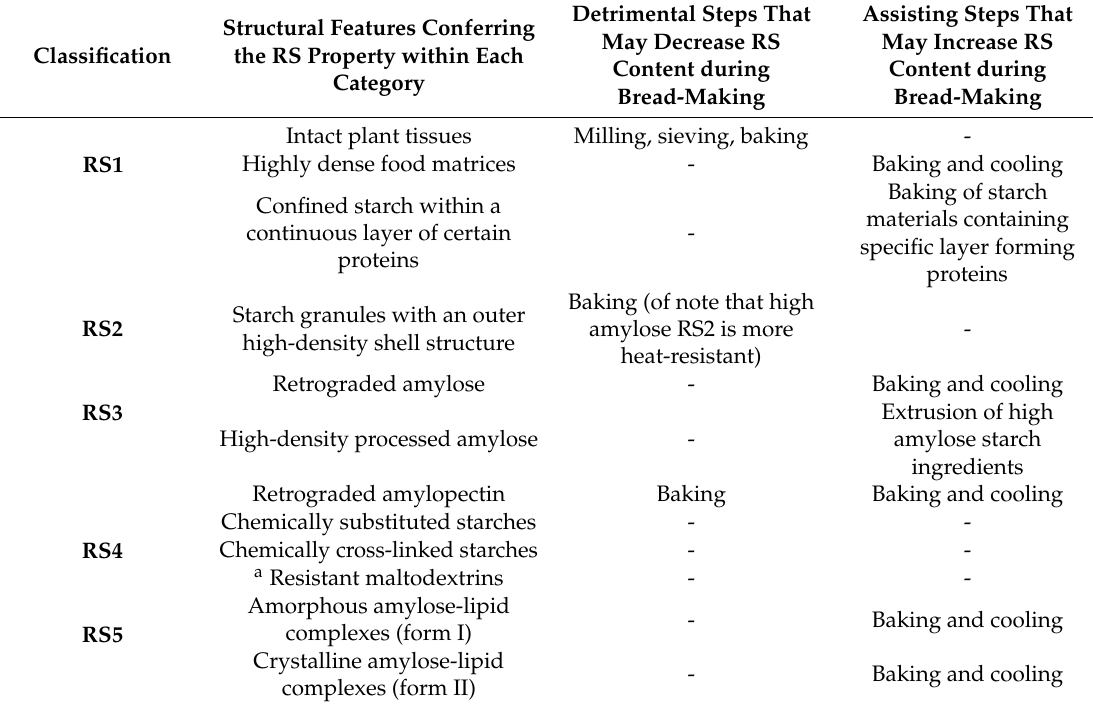
Table 1. Structural features conferring the resistant digestion property within each clean-label resistant starch (RS)